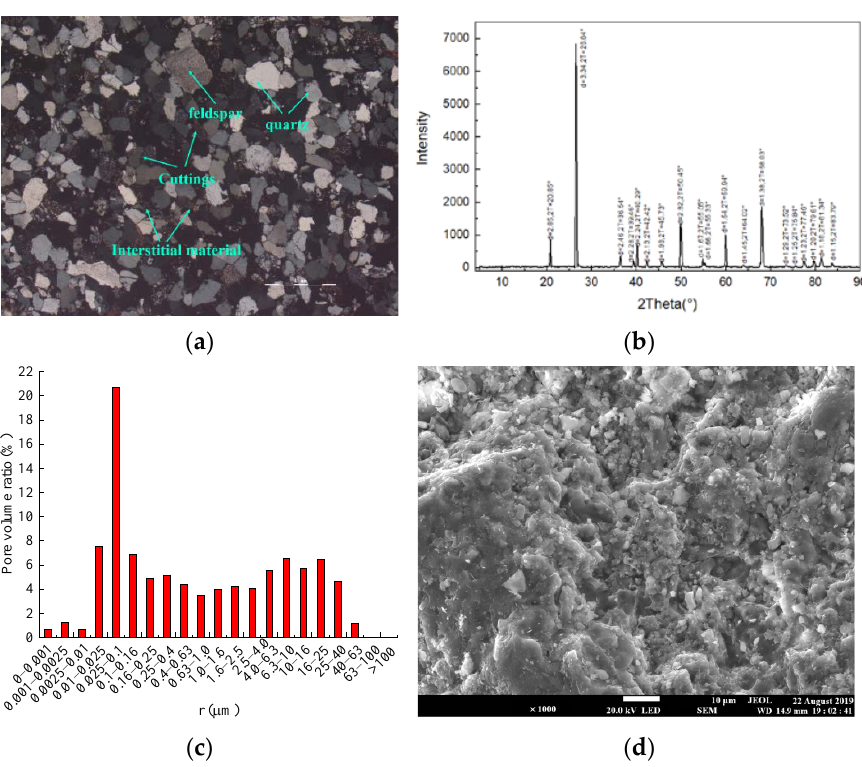
Figure 2. The detailed observation attempt of the specimen: ( a ) Structure observed by polarized light microscope, ( b ) X-ray diffraction (XRD) pattern, ( c ) Magnetic resonance imaging (MRI) pore radius map, ( d ) Scanning electron microscope (SEM) pattern. Table 1. Test scheme of fractured and intact sandstone